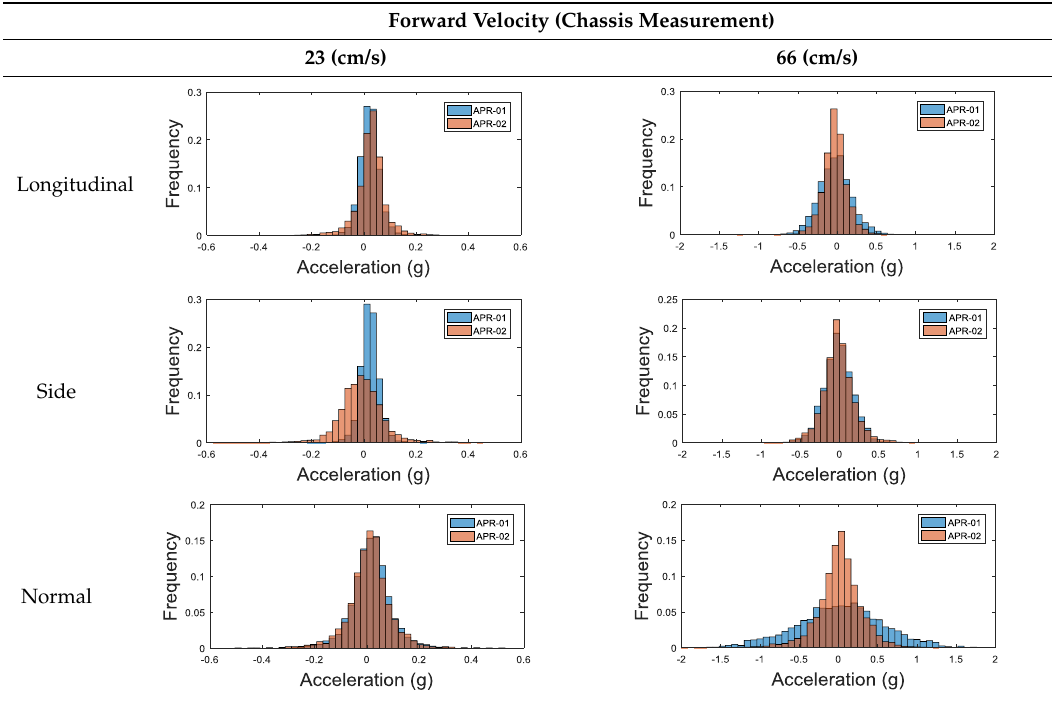
Table 7. Vibration pattern histograms measured in the chassis of the two APR prototypes.